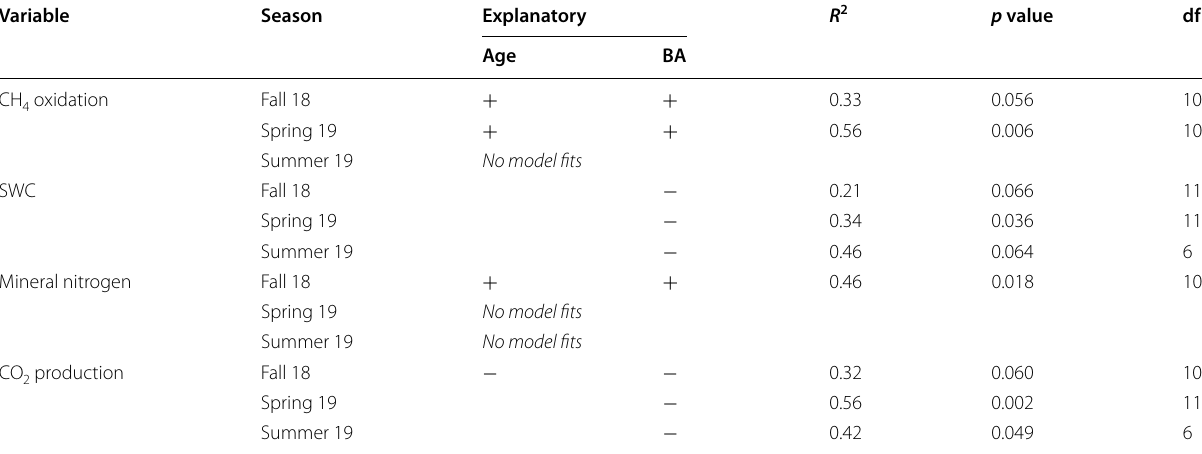
ANOVA p values and adjusted R 2 of the best models are presented. The direction of the effects of each factor are indicated ( was not included in the table because no model fitted the data at any of the dates